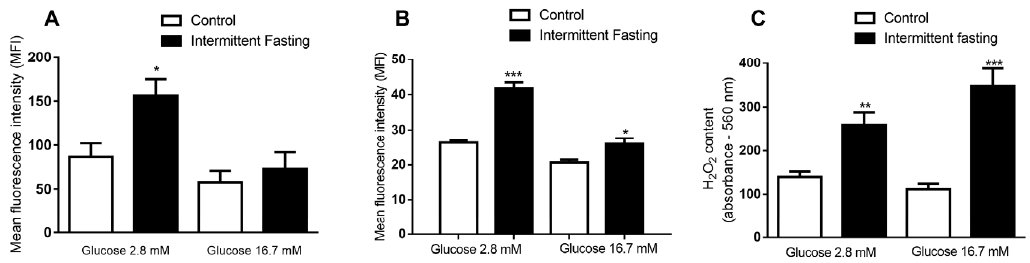
Figure 13. ( A ) Mean fluorescence intensity (MFI) emitted by a dihydroethidium (DHE) probe, ( B ) MFI emitted by a MitoSox Red probe, and ( C ) the absorbance emitted by the Amplex Red probe of dispersed cells from a pancreatic islet isolated from Wistar rats submitted to IF for 12 weeks after one hour of incubation in the presence of 2.8 and 16.7 mM glucose. The results are presented as the means ± standard error of the mean (EPM) with 6 di ff erent cellular preparations for each group. * p < 0.05, ** p < 0.005, and *** p < 0.0005, compared to the respective control, as indicated by Student’s t-test. Net mitochondrial ROS production was also measured in the presence of 2.8 and 16.7 mM